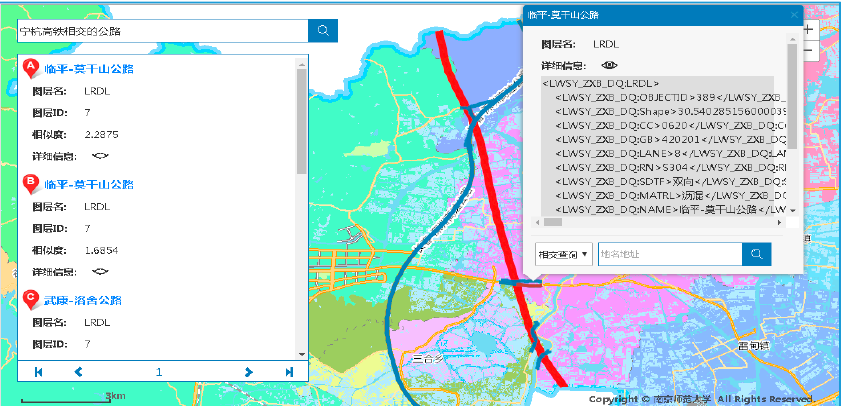
Figure 15. “Highways intersecting with the Ning-Hang highway.”